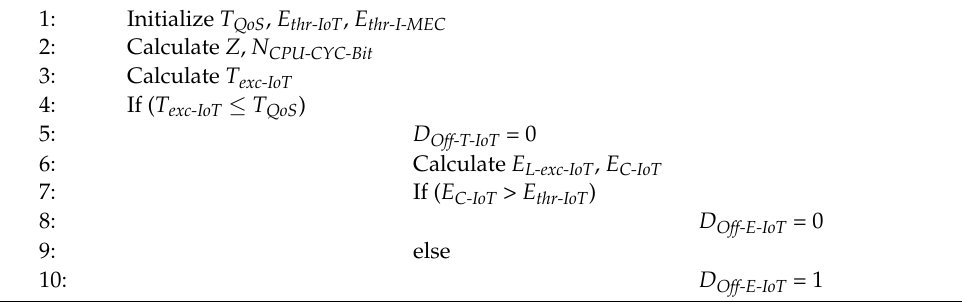
Algorithm 1 Latency-aware and energy-aware offloading algorithm for MEC-based IoT